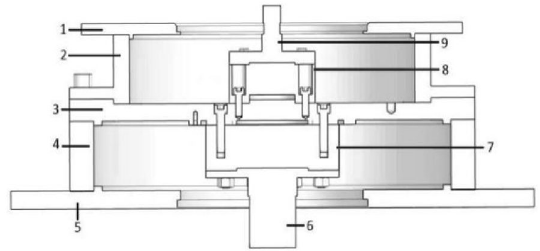
Figure 6. The instrument deformation calibration device. In the figure: 1. Top cover; 2. Input barrel; 3. Intermediate plate; 4. Output barrel; 5. Base; 6. Spline shaft at output side; 7. Spline shaft fixing block at output side; 8. Spline shaft fixing block at input side; 9. Input side spline shaft.